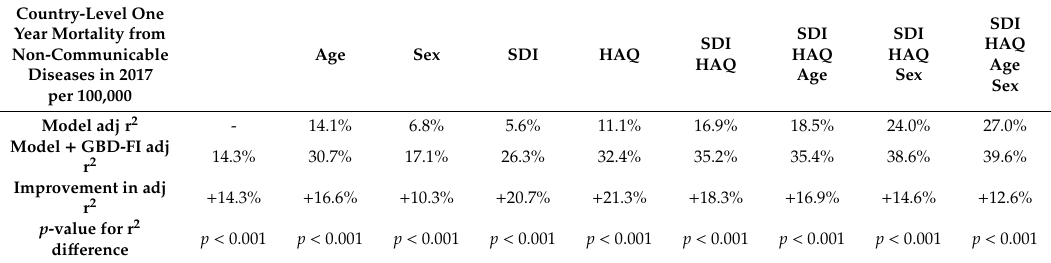
Table 3. Goodness of fit of models (adjusted r 2 values) for predicting mortality from non-communicable diseases at the country level ( n = 195), adjusting for di ff erent combinations of Age (population proportion aged ≥ 85), Sex (population proportion female), SDI index (measure of development), and HAQ index (measure of health care function) and mean GBD-FI score. The absolute proportional change (%) in r 2 caused by adding mean GBD-FI score (improvement in fit / prediction of model) is